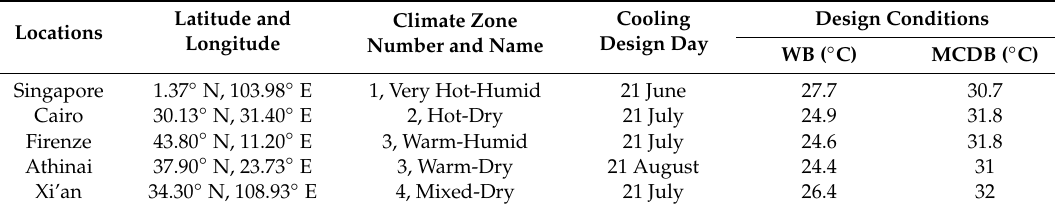
Table 1. Climate zones and design conditions for the selected